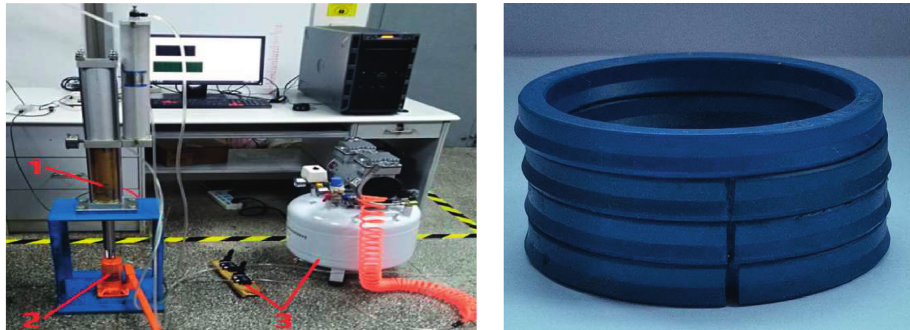
Figure 2: (a) Image of the test rig. (b) Image of the seal rings with notches of different sizes.